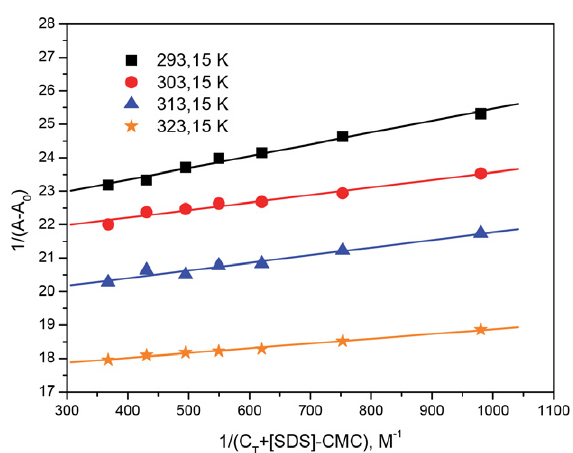
Figure 6. Plot of 1/(A-A 0 ) versus 1/(C T + [SDS]-CMC) for the inter- action of quinizarin with SDS micelles at various temperatures.